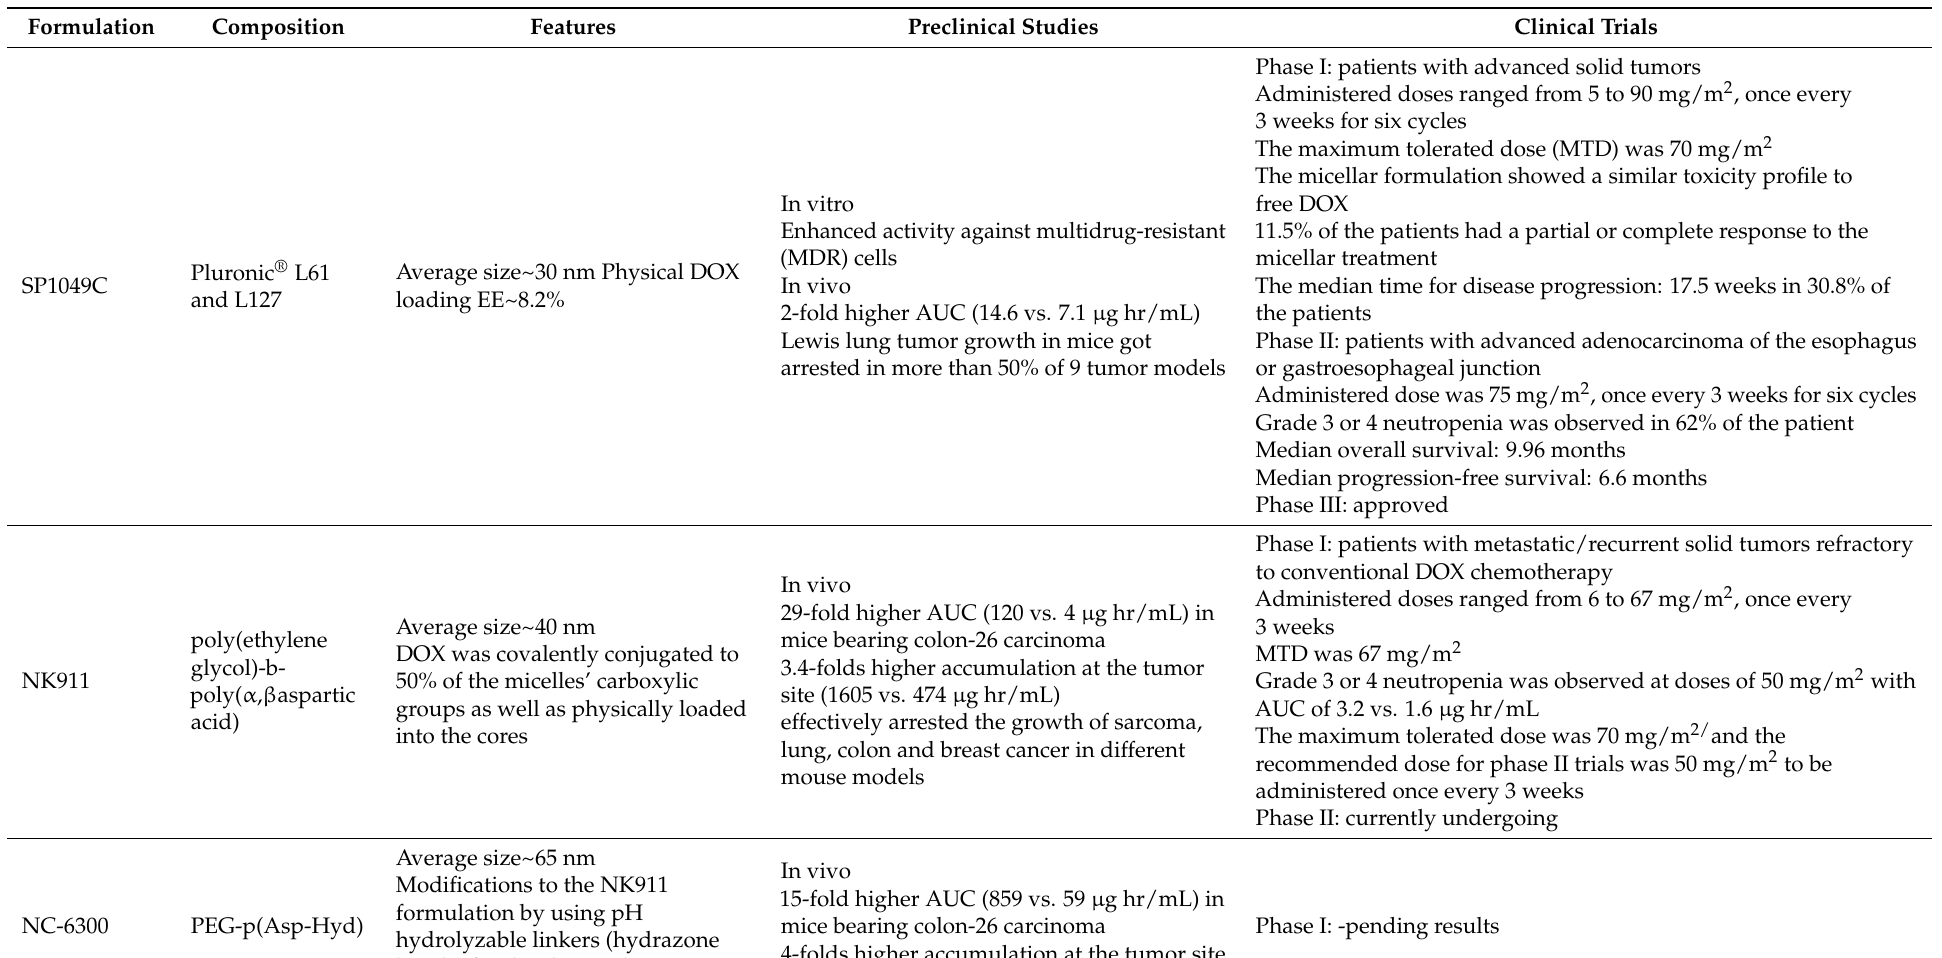
Table 4. Summary of preclinical and clinical evaluations of some micellar-based DOX DDS. All presented comparisons are against treatment with free